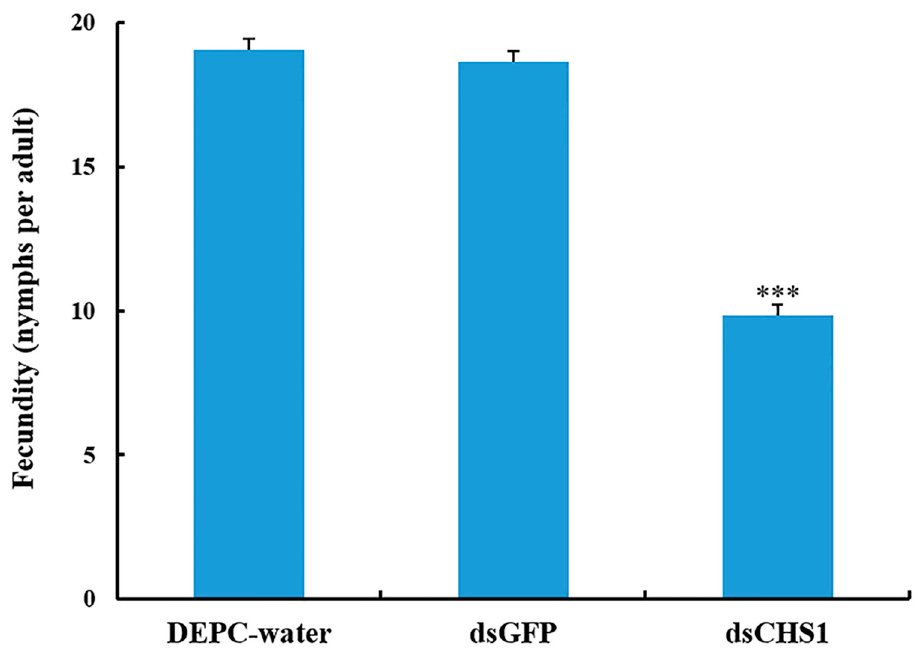
Figure 5. E ff ect of CHS1 gene silencing on fecundity of A. gossypii , previously fed artificial diets containing DEPC-water, dsGFP, and ds CHS1 at their nymphal stage (third instar). The values are presented as the mean ( ± SE). Thirty individuals per experimental group (DEPC-water, dsGFP, and dsCHS1) were used and each aphid was considered as a single replicate. Treatments were compared using one-way ANOVA (Tukey’s HSD test, p < 0.05). *** represents p < 0.001.